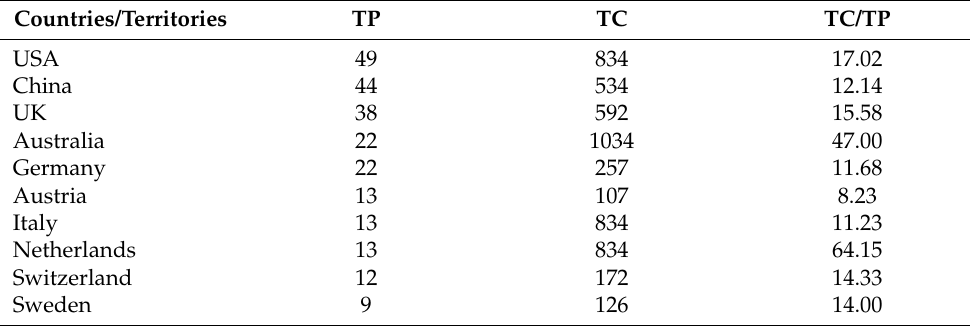
Table 2. Countries with the highest number of publications (Top 10).